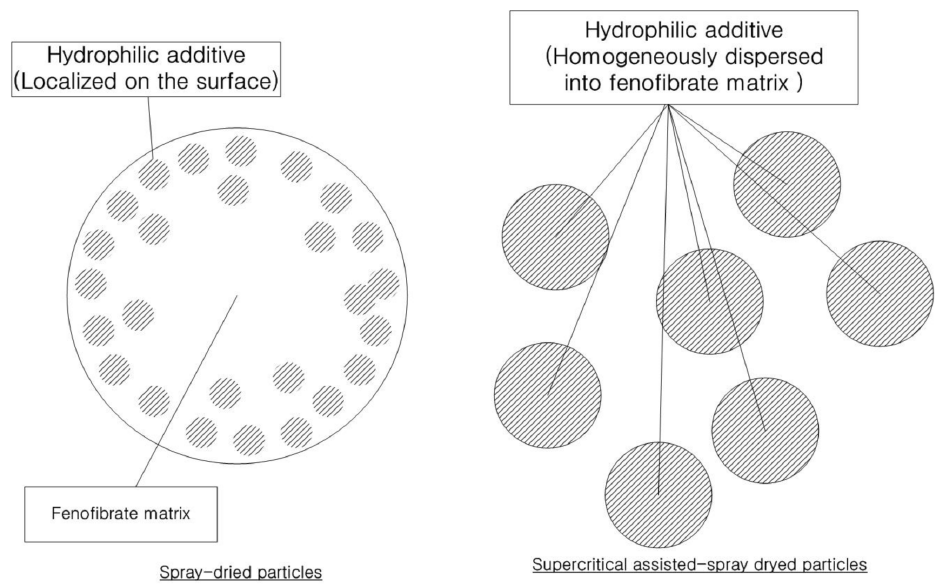
Figure 7. The schematic representation of the fenofibrate microparticles prepared using the SA-SD process and the SD